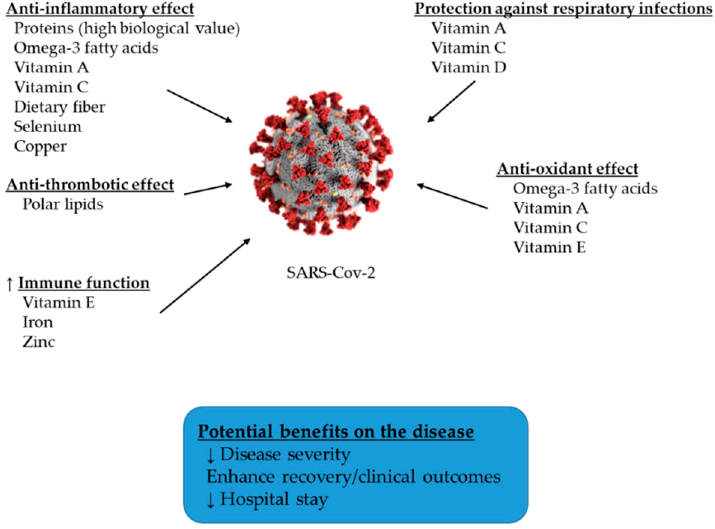
Figure 2. Effects of several nutrients on aspects of COVID-19 infection. ↑ : increase, ↓ : decrease.